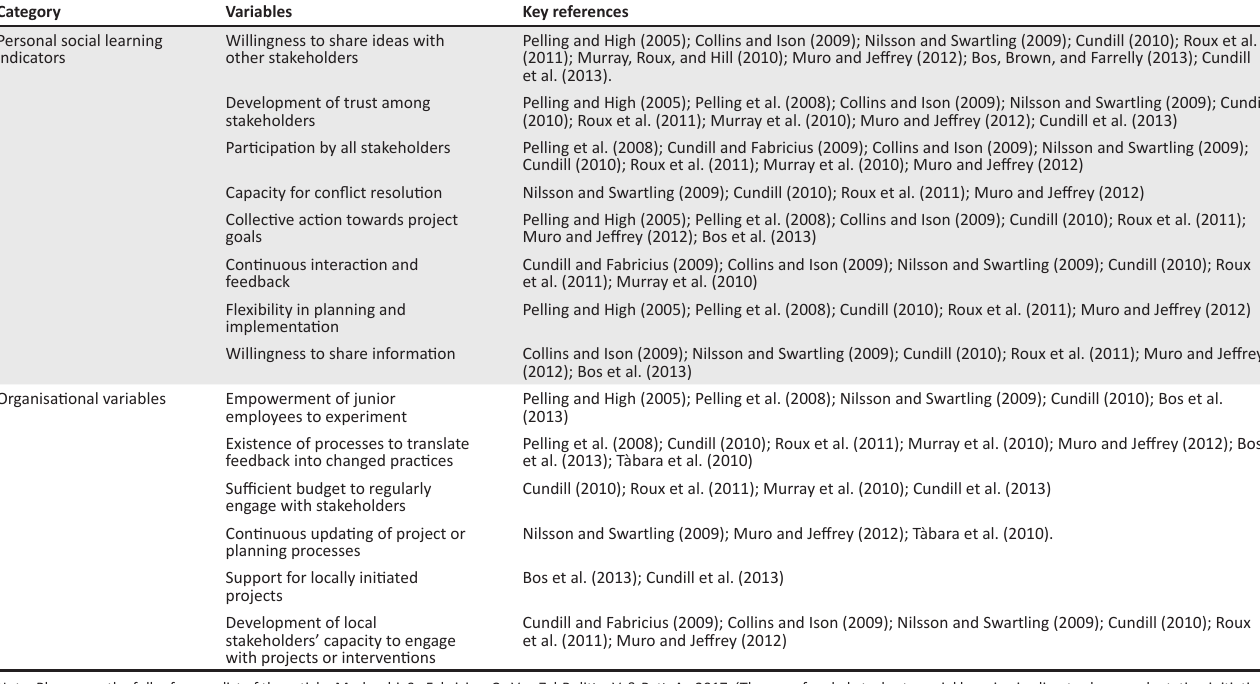
TABLE 1: Social learning variables used.